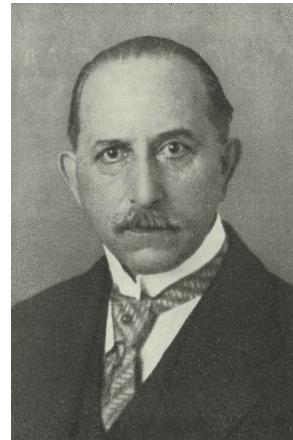
Figure 13. Alfred Nippoldt’s portrait. Source: Bock (1937).